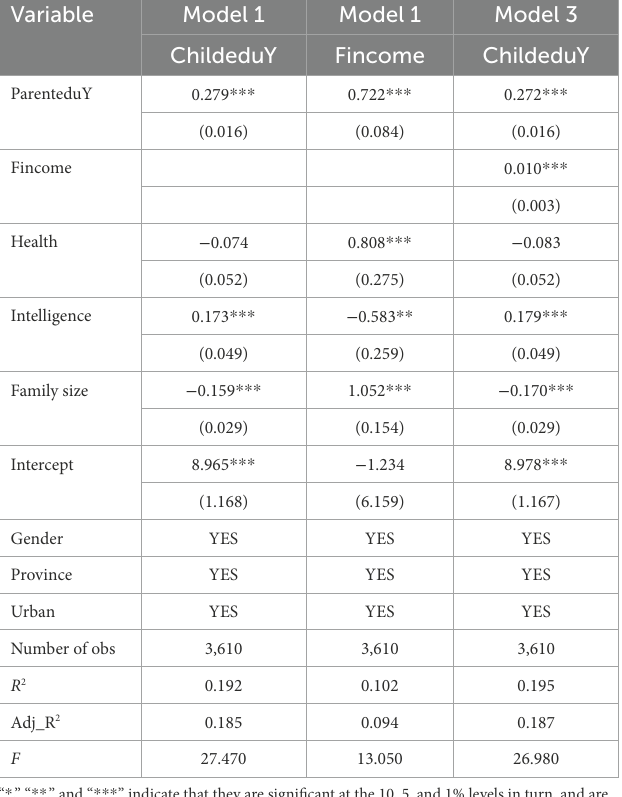
TABLE 4 Results of the mediating effect of household income on the intergenerational transmission of education.